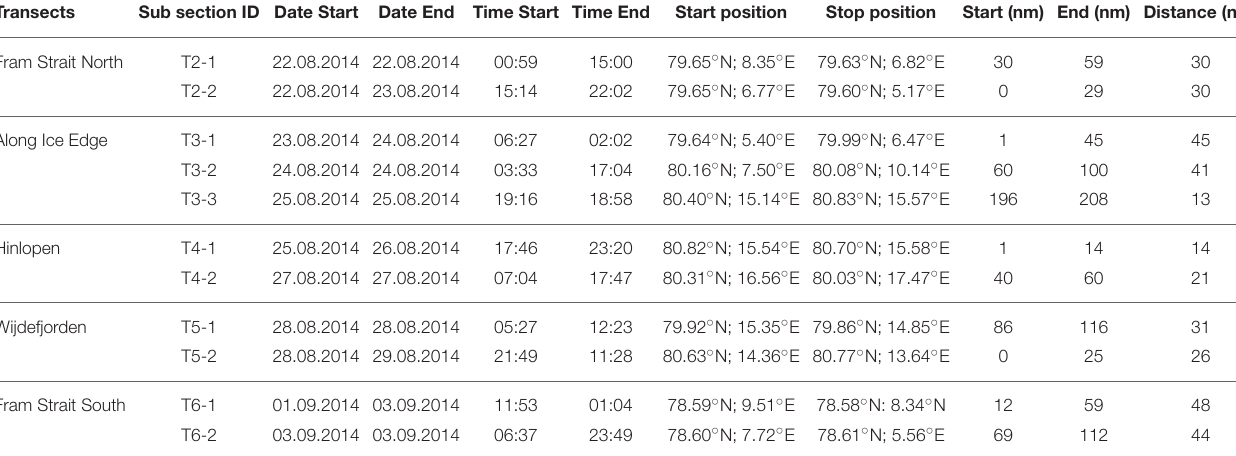
TABLE 2 | Logistics information for acoustic subsections within Transect 2 to Transect 6 (T2–T6).